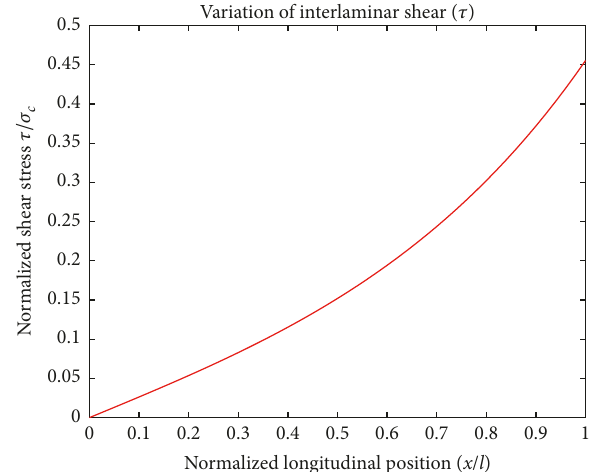
Figure 5: Variation of interlaminar shear in 0/90 interface for a glass fiber/epoxy cross-ply [0/90] s composite using Berthelot-modified shear-lag model [12].